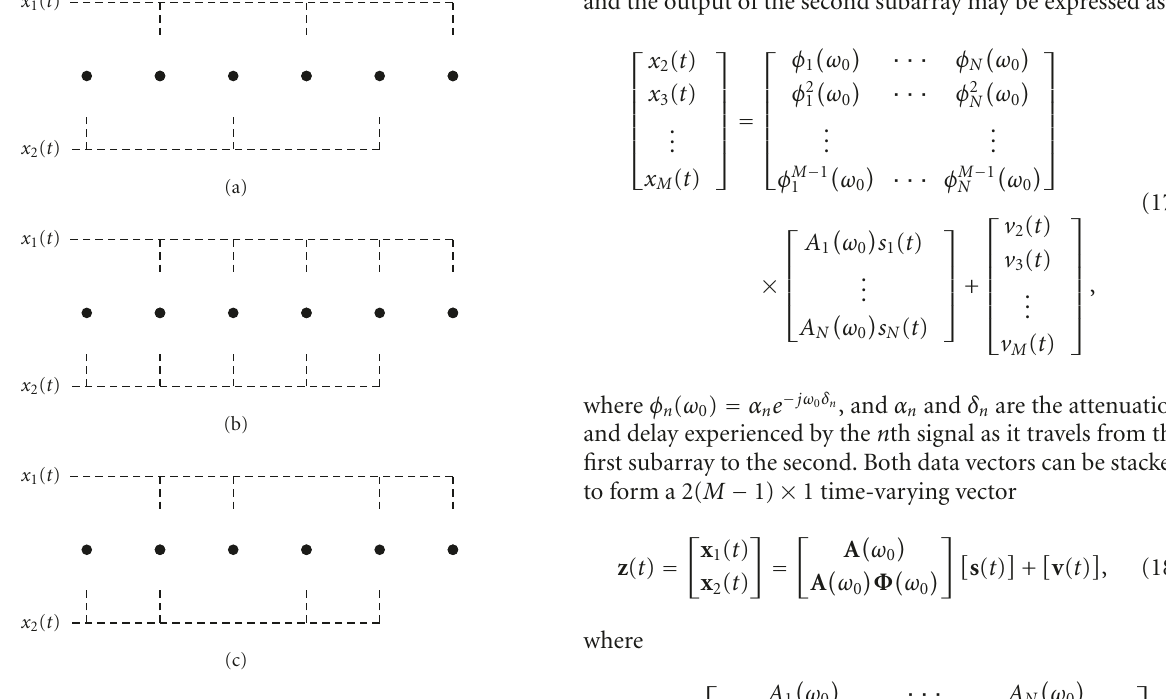
Figure 2: ESPRIT subarray separation of a uniform linear array in the case of M = M/ 2, M = M − 1, and M/ 2 < M < M − 1.